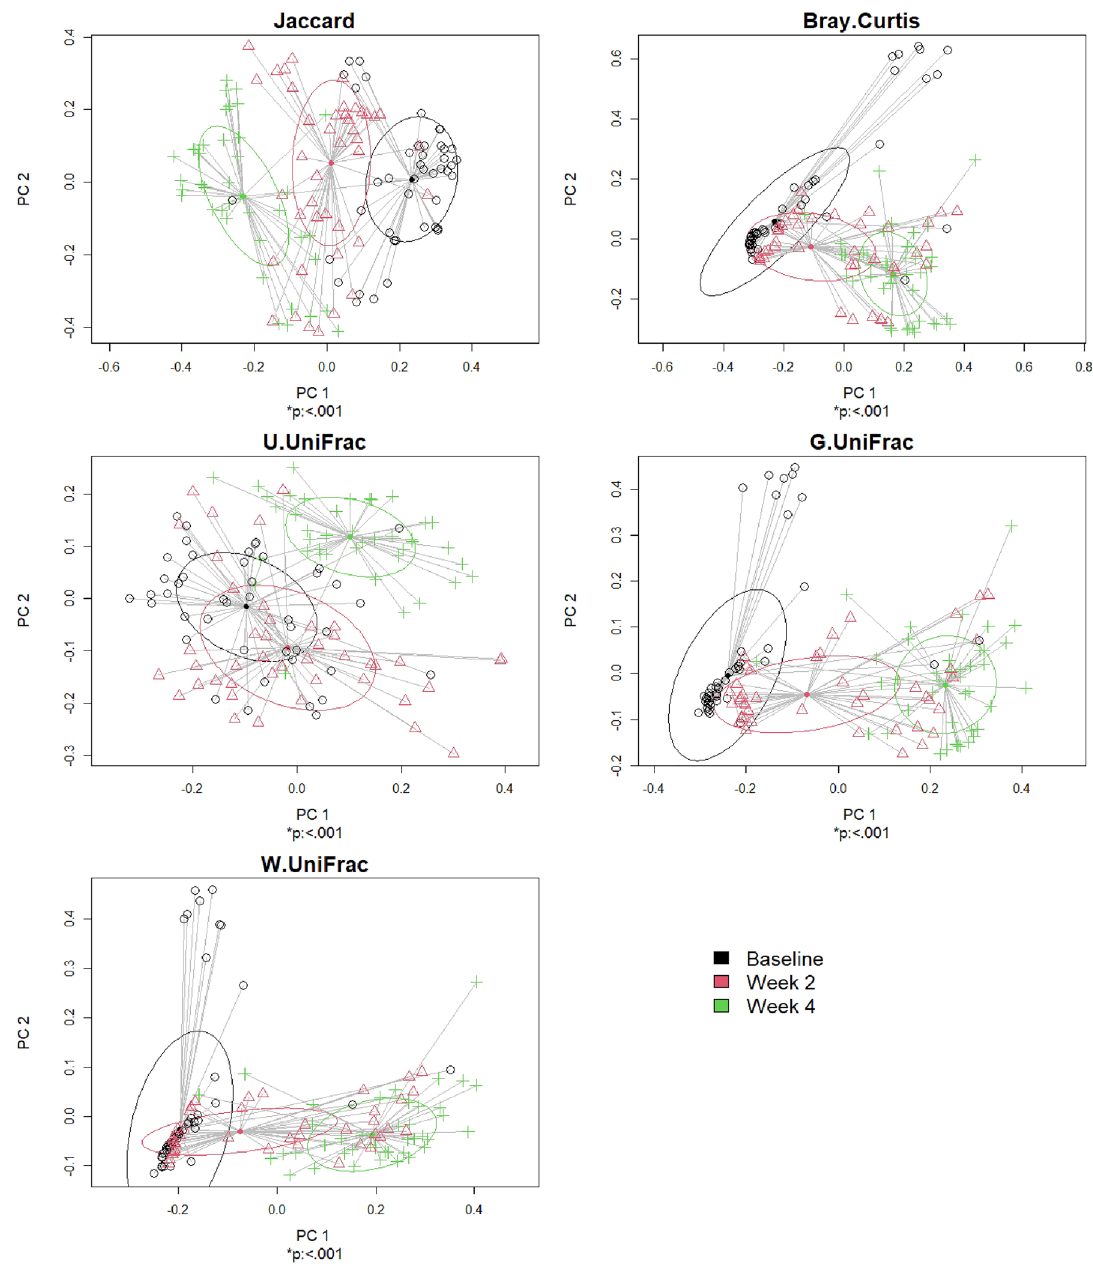
Figure 4. The results for comparitive analysis in beta-diversity (global test). The p-values were calculated using PERMANOVA for global testing if all groups have the same microbiome composition in each beta-diversity index ( H 0 ) or if at least one group has a different microbiome composition in each beta-diversity index ( H 1 ). *p represents statistical significance at the level of